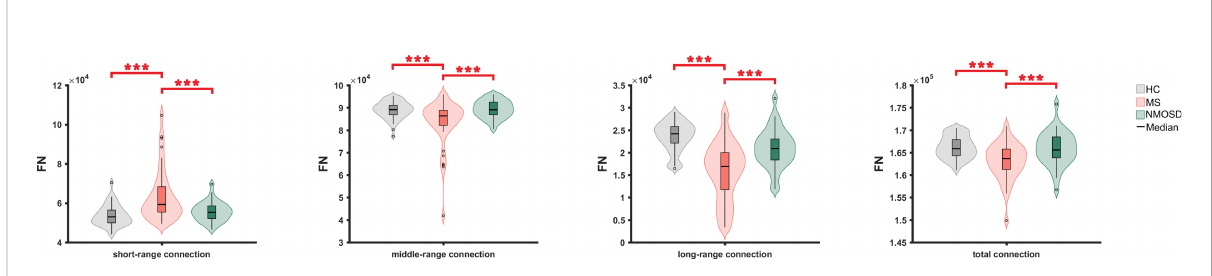
FIGURE 2 The FN comparison of short-, middle-, long- and total fi ber connections between three groups. FN, fi ber number ; *: <0.05, **<0.01, ***<0.001.